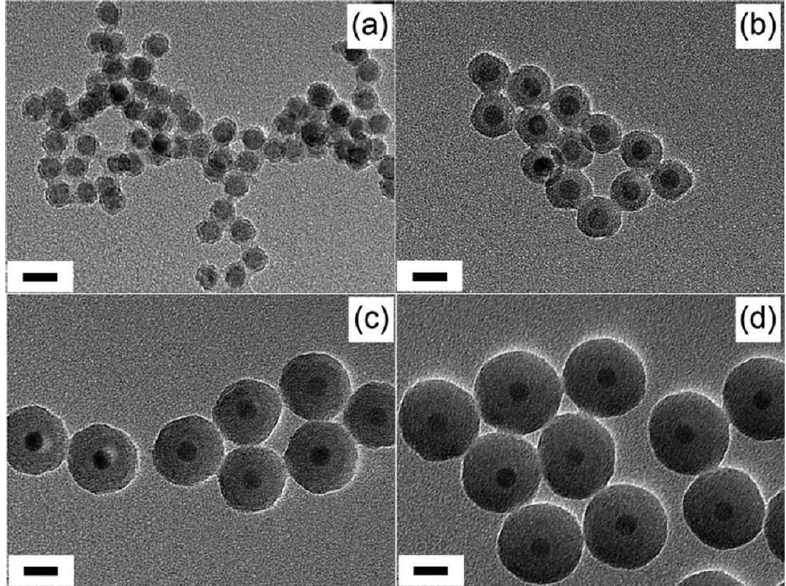
Figure 2. Transmission electron microscope (TEM) image of 12.2-nm Fe 3 O 4 @SiO 2 nanoparticles (NPs) with shell thicknesses of ( a ) 2.0 nm, ( b ) 6.3 nm, ( c ) 14.1 nm, and ( d ) 19.8 nm. Scale bar = 20 nm. Reproduced with permission from [65]. Copyright American Chemical Society, 2012.